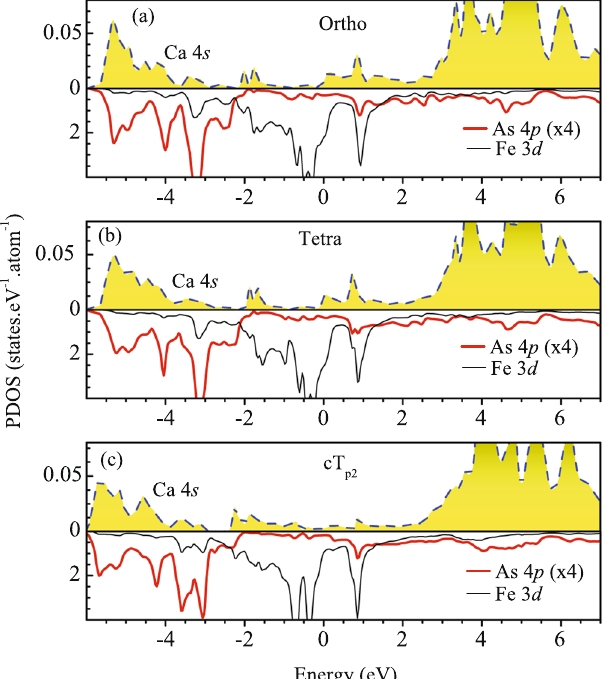
Figure 17. Ca 4 s PDOS (area plot) is compared with As 4 p (thick solid line) and Fe 3 d (thin solid line) for ( a ) orthorhombic, ( b ) tetragonal and ( c ) collapsed tetragonal structures. The As 4 p contributions are rescaled by 4 times for better